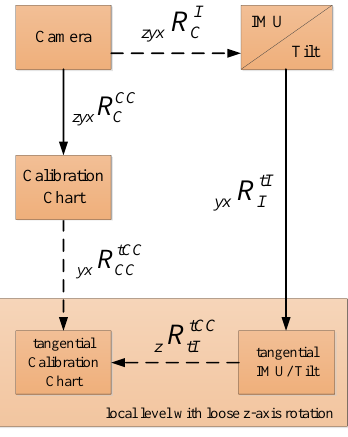
Figure 6: IPS rotatory connections left subscript zyx of the direction cosine matrix R (Titterton and